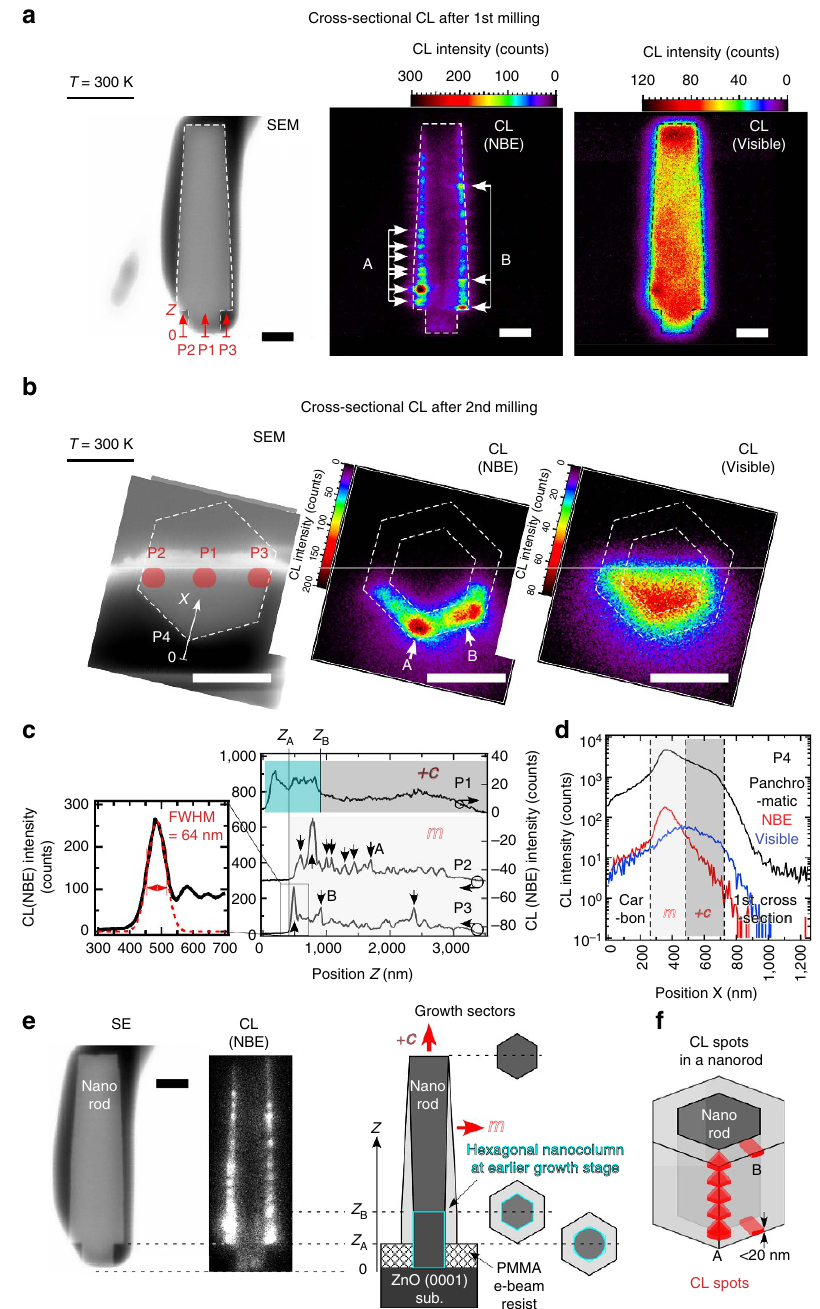
Figure 4 | High-resolution cross-sectional CL imaging of a micro-sampled nanorod. SEM and CL (NBE/Visible) images of first axial cross-section ( a ) and those of second basal cross-section ( b ), both of which are probed by 3.0keV e-beam. Original nanorod volume is indicated by dashed line for eye-guide. ( c ) NBE CL profiles P1–P3 along coordinates Z at P1–P3 in a . CL spatial resolution is evaluated from FWHM of profile P3 around the sharpest CL spot. ( d ) CL (Panchromatic/NBE/Visible) profiles along coordinate X . ( e ) Schematic representation of þ c and m growth sectors within the nanorod cross-section, revealed from comparison between SEM and NBE CL images. Nanorod bottom ( Z ¼ Z A ) and slight NBE CL intensity drop in þ c growth sector ( Z ¼ Z B ) are also indicated in c , e . CL profiles P1–P4 and a hexagonal nanocolumn at earlier growth stage are indicated by aqua zones and schematically by an aqua box in a þ c growth sector. All scale bars indicate lengths of 0.5 m m. ( f ) Schematic illustration of spatial distribution and shape of CL spots. Observed CL spots in a – c are indicated by solid arrows and categorized into either spot A or spot B by their shape and